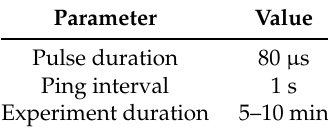
Table 4. Echosounder parameters used during data collection of short experiments.